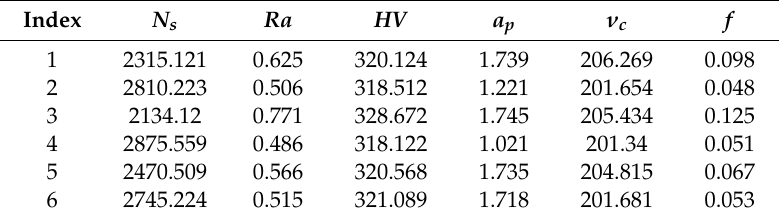
Table 12. Partial Pareto front points by